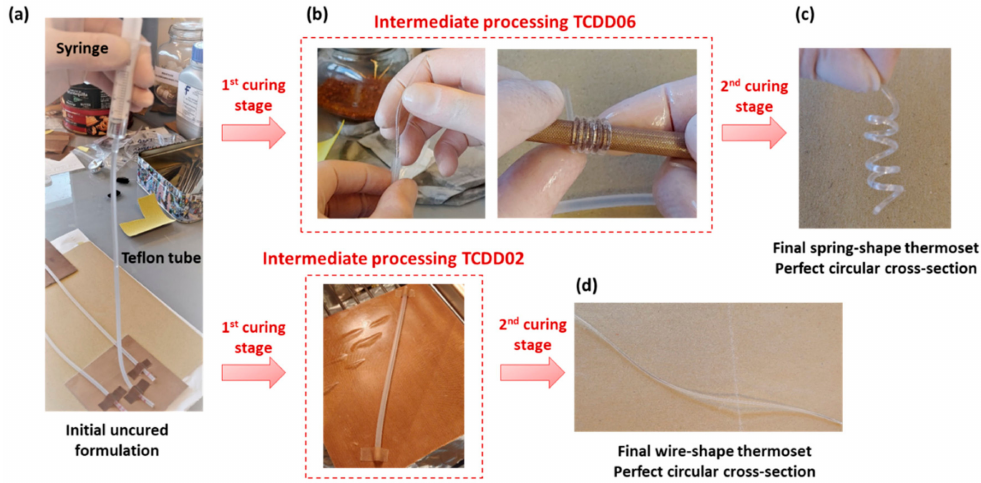
Figure 10. Preparation of a spring-shaped ( c ) and wire-shaped ( d ) samples from, respectively, TCDDA06 and TCDDA02 formulations ( a , b ).